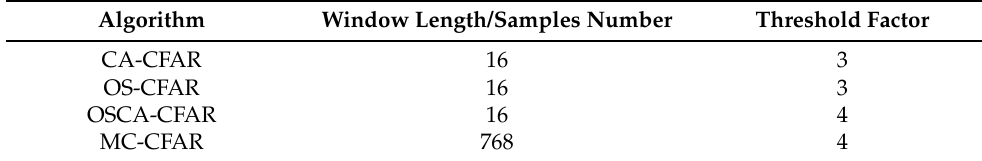
Table 4. CFAR algorithm parameter